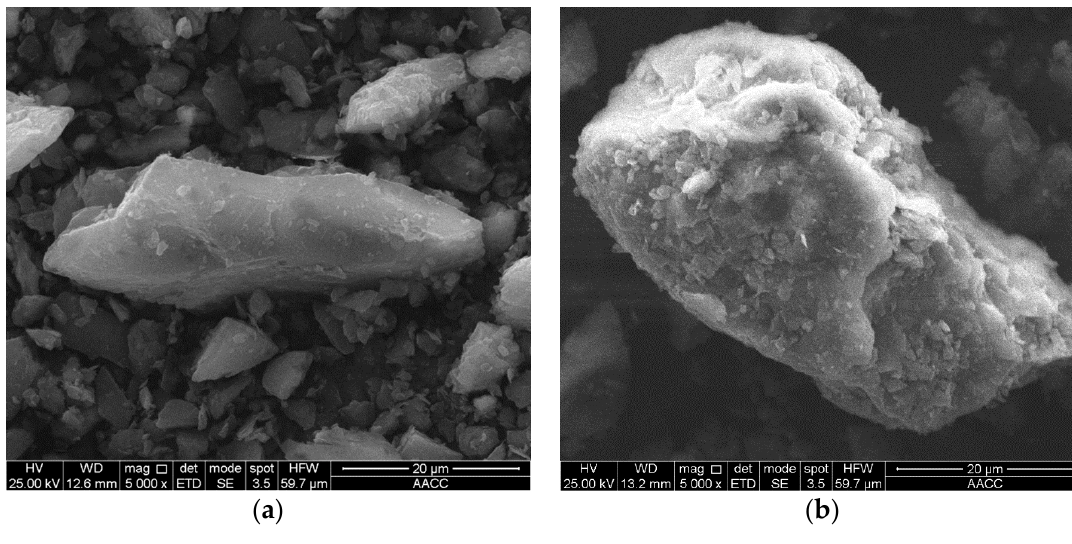
Figure 1. SEM images of fresh ( a ) and oxidized coal ( b ).